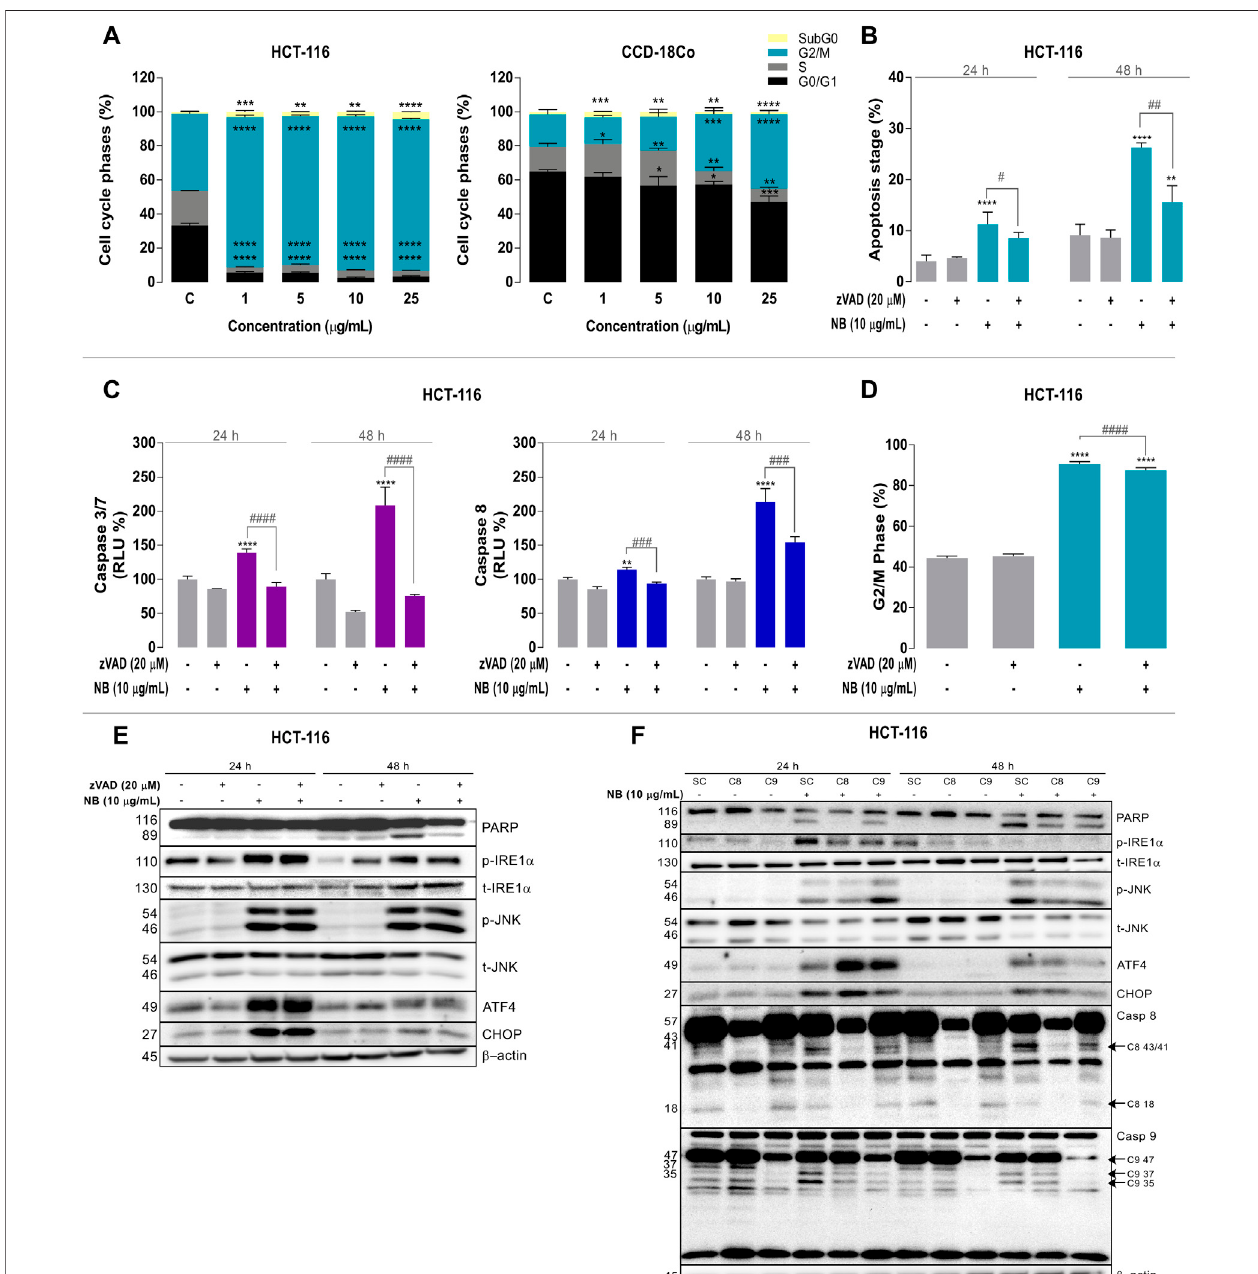
FIGURE 3 | Relationship among ER stress, cell cycle modulation, and caspase-dependent apoptotic cell death in colon cancer cells treated with Dolabella auricularia extract(NB). (A) EffectofincreasingconcentrationsofNBextractonthecellcycleofHCT-116andCCD-18Cocellsafter24 h.HCT-116cellswerepretreated witha pan-caspase inhibitor, zVAD (20 μ M), for2 h prior tothe addition of10 μ g/ml NBextract for 24 h to study the effect of NBextract on apoptosis. (B) Measurement of apoptotic cells (% Annexin V positive cells), (C) caspases 3/7 and 8, and (D) the G2/M phase. Data are presented as the mean ± SD of three independent experiments. p -valueswerecalculatedbycomparisonwiththeuntreatedcellline(*)andNBcondition( # )usingANOVA.*or # p -value < 0.05,**or ## p -value < 0.01,***or ### p -value < 0.001,and****or #### p -value < 0.0001.TheeffectsofNBextracton themodulation ofERstress – related proteins and apoptosiswereanalyzedbywestern blot analysis. The effect of NB extract on ER stress – related proteins (E) and its relationship to caspase activation (F) . Caspases 8 and 9 in HCT-116 were silenced with siRNA, and cells were treated with 10 μ g/ml NB extract for 24 h. ER stress – related proteins (PARP, phospho-IRE1 α , total-IRE1 α , phospho-JNK, total-JNK, ATF4, CHOP,andcaspases8and9)wereanalyzedbywesternblotanalysis. β -Actinwasusedasaloadingcontrolinthewesternblotassay.Densitometryanalysesof E and F are shown in Supplementary Figures 3 and 4 , respectively.